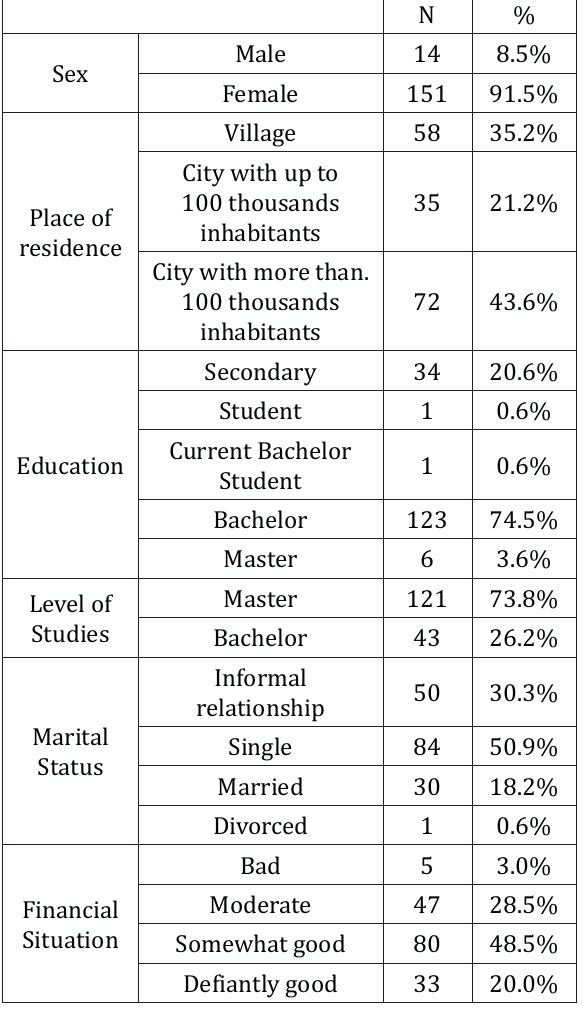
Table 1. Characteristics of the studied